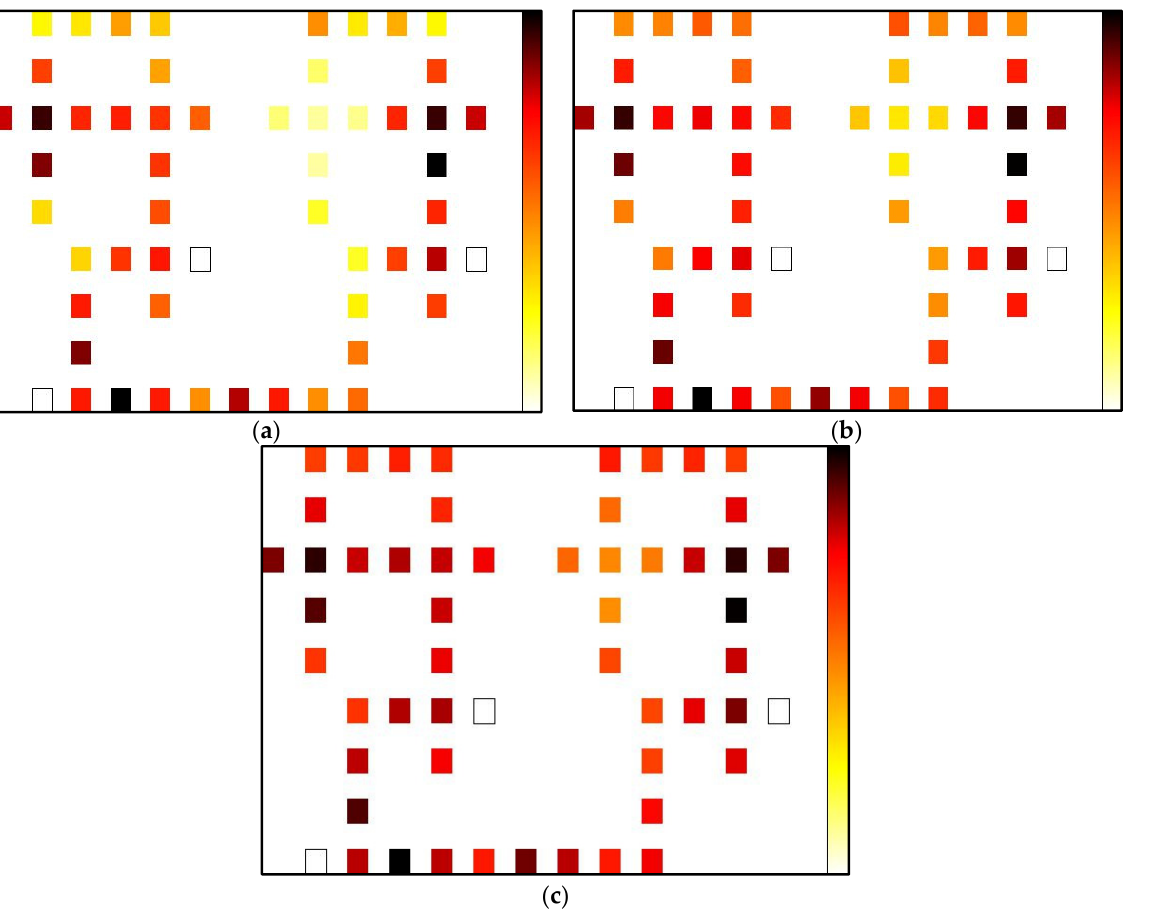
Figure 23. Map of energy dissipation for proposed 2-bit PIPO shift register at T = 2K and ( a ) 0.5 Ek, ( b ) 1.0 Ek, ( c ) 1.5 Ek γ -factor. 1.77 × 10 − 2 eV is the approximate value of energy dissipated by the proposed 2-bit PIPO